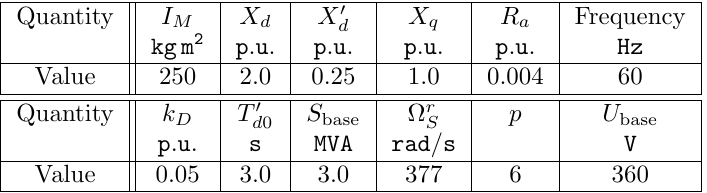
Table 1: The Parameters of the synchronous machine